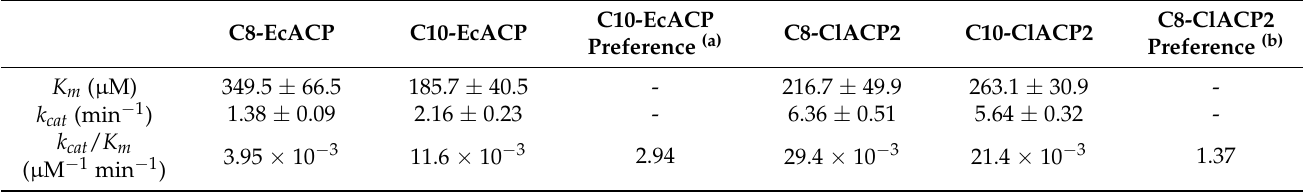
Table 1. The enzymatic constants of ChFatB2 with